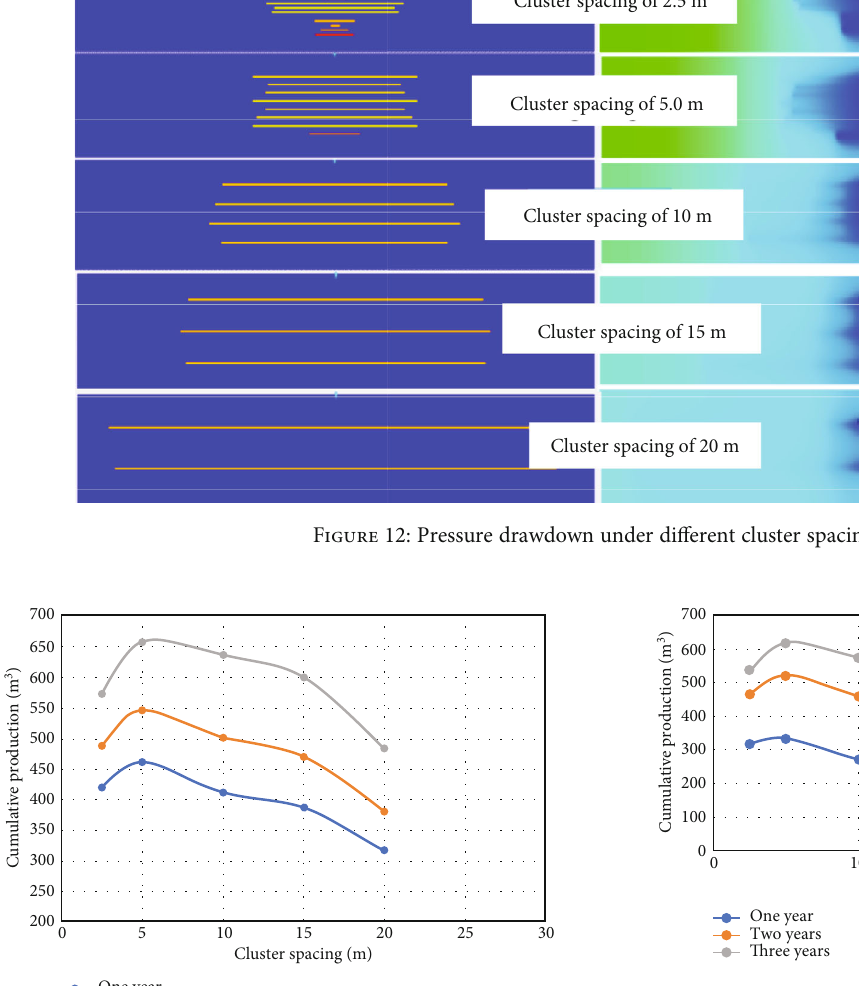
Figure 14: Cumulative production under di ff erent cluster spacings at 200m well